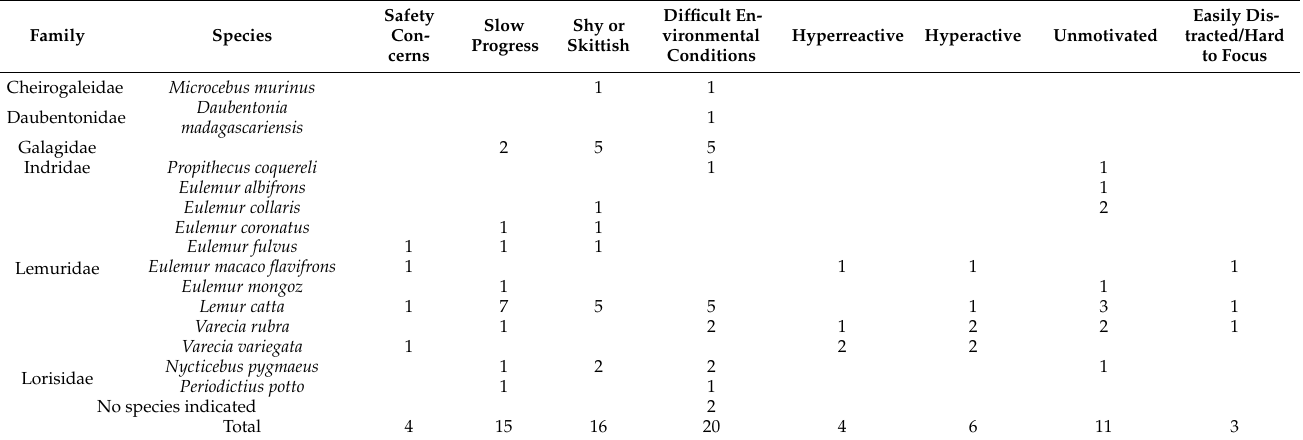
Table 3. Number of institutions reporting challenges in training Strepsirrhine